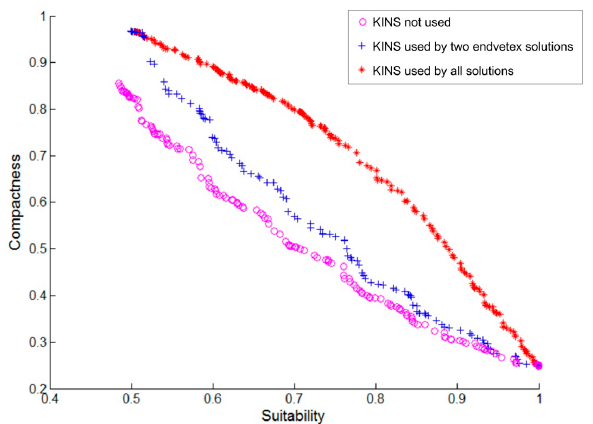
Figure 18. Comparison of different applications of knowledge-informed neighborhood search (KINS).